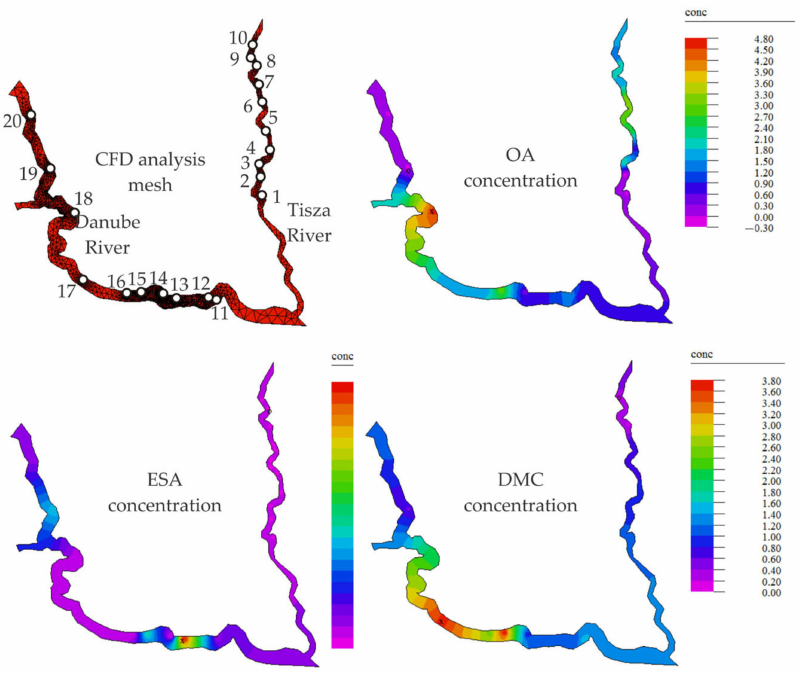
Figure 9. The geographical distribution of OA, ESA, and DMC concentrations detected in water samples from sampling sites in Daunbe River and Tisza River. OA—dimethachlor oxalic acid, ESA—dimethachlor ethanesulfonic acid and